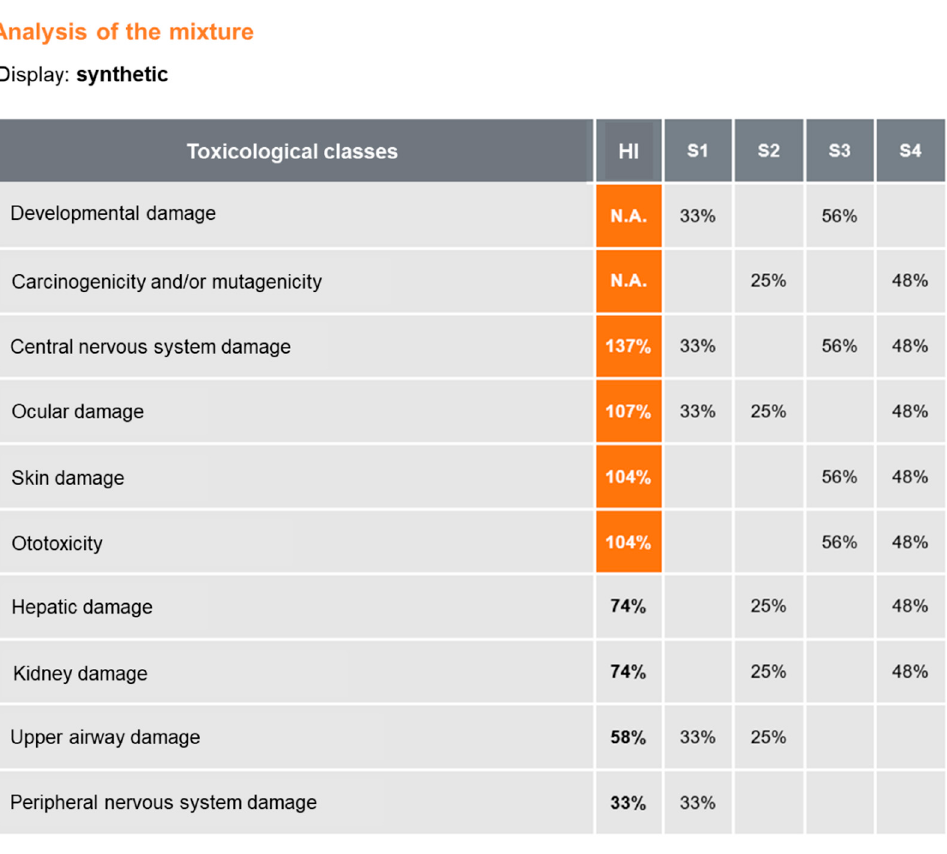
Figure 3. Analysis of the mixture with Hazard Index calculation (quantitative mode).